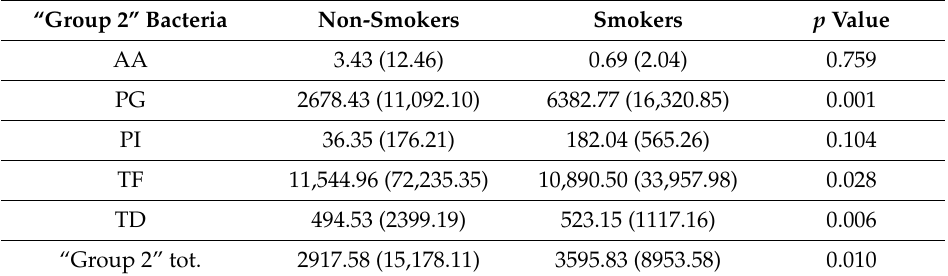
Table 7. Correlation between microbial species and smoking habit. Mean